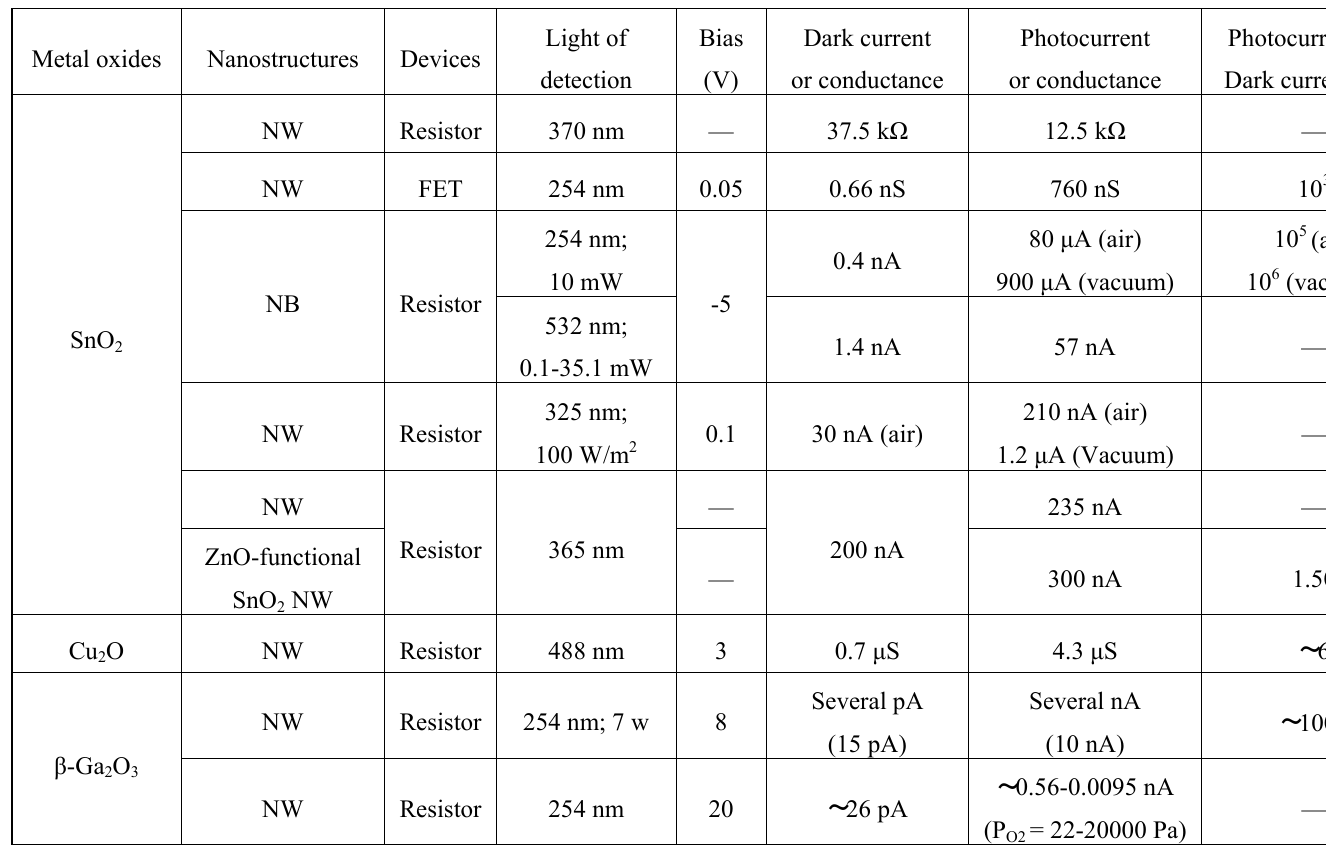
Table 3. Metal oxide-based